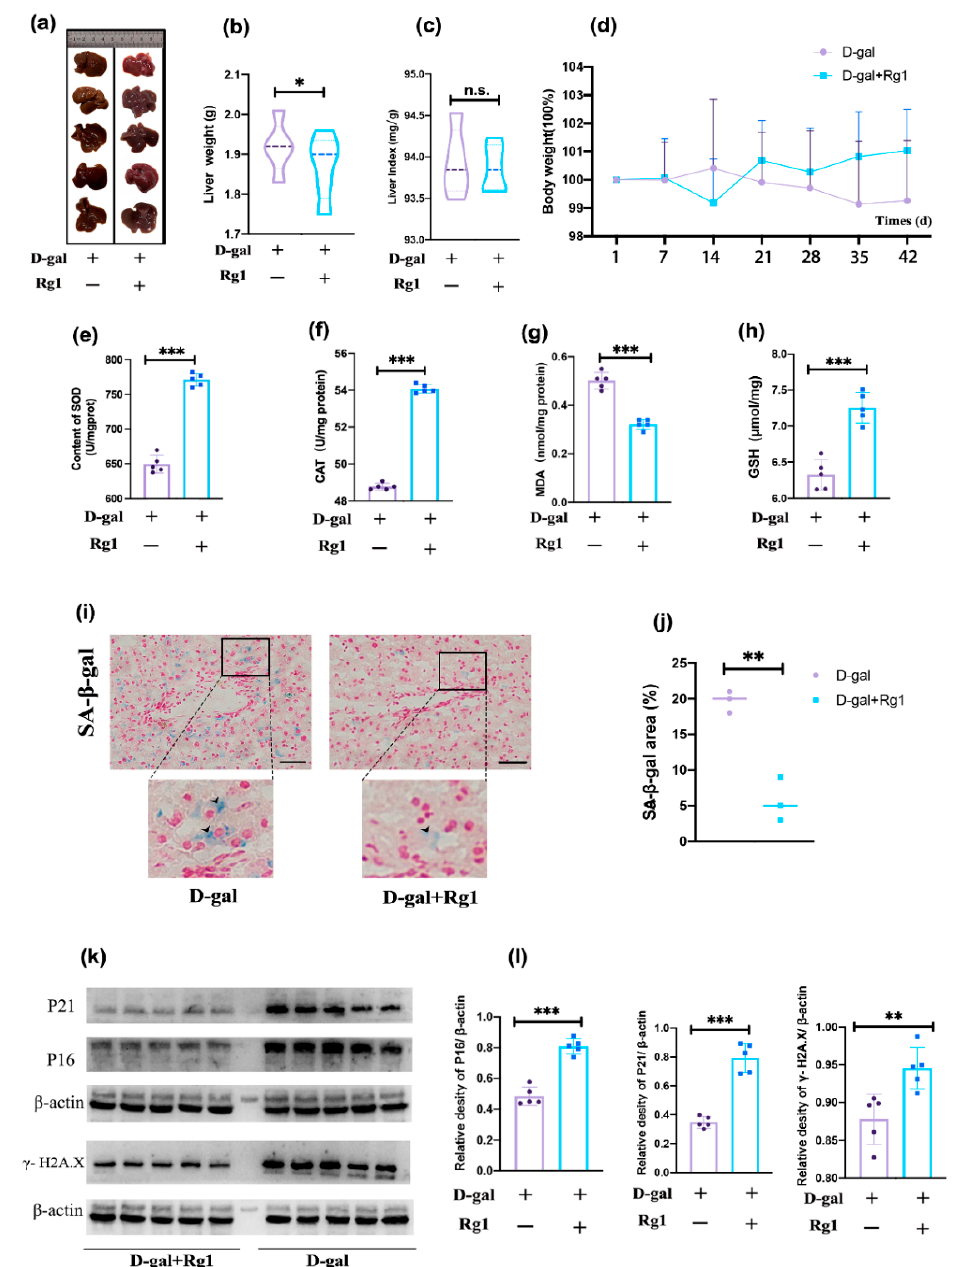
Figure 1. After D-gal treatment, the hepatocytes showed a decrease in the ability of anti-oxidative stress and senescence-associated cellular dysfunction, which can be alleviated by Rg1. ( a ) The appearance of the livers of each group. ( b ) The weight of livers was examined ( n = 5/group). ( c ) The liver Index (liver weight/body weight) was measured ( n = 5/group). ( d ) Daily weight was recorded to plot the weight gain curve. The levels of ( e ) SOD ( f ) CAT ( g ) MDA and ( h ) GSH in the liver of mice was examined ( n = 5/group). ( i ) SA- β -gal staining showed the SA- β -gal+ cells and ( j ) the percentage of positive cells was detected (magnification, ×400, scale bar, 20 µm, n = 5/grp). Images were analyzed using Image J software (Version 1.52). ( k ) Western blotting for P16, P21, and γ - H2A.X expression levels. ( l ) The relative density of the bands was calculated. β -actin served as the internal control. Data represented by means ± SD in ( b , c , e – j ). (* p < 0.05; ** p < 0.01; *** p < 0.001 and n.s., not statistically significant. Student’s t -test).